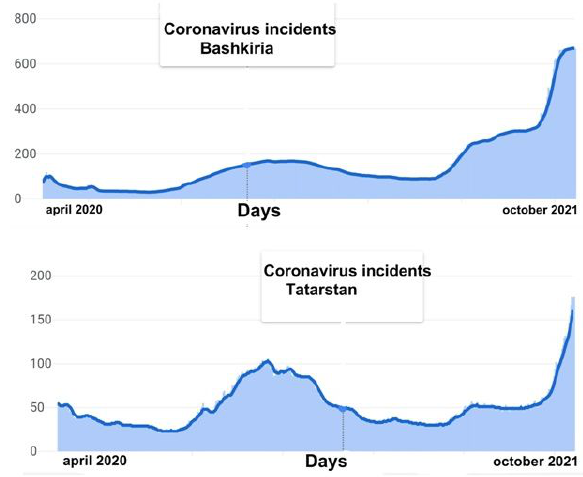
Figure 6. Dynamics of coronavirus incidents from April 2020 to October 2021. Above – Bashkiria, below - Tatarstan Let’s compare the current incidence in the republics of Bashkiria and Tatarstan. (Russia). Bashkiria has a domi- nant haplogroup R1b. The number of coronavirus cases is 4 times less in the neighboring republic of Tatarstan with other genetic characteristics of the population. The pop- ulation of Tatarstan is a mixture of major European hap- logroups with a slight predominance. Figure 6 shows the number of coronavirus incidents in Bashkiria and Tatarstan now (700 versus 150, respectively). Russia versus 30% in southern Russian territories. At the